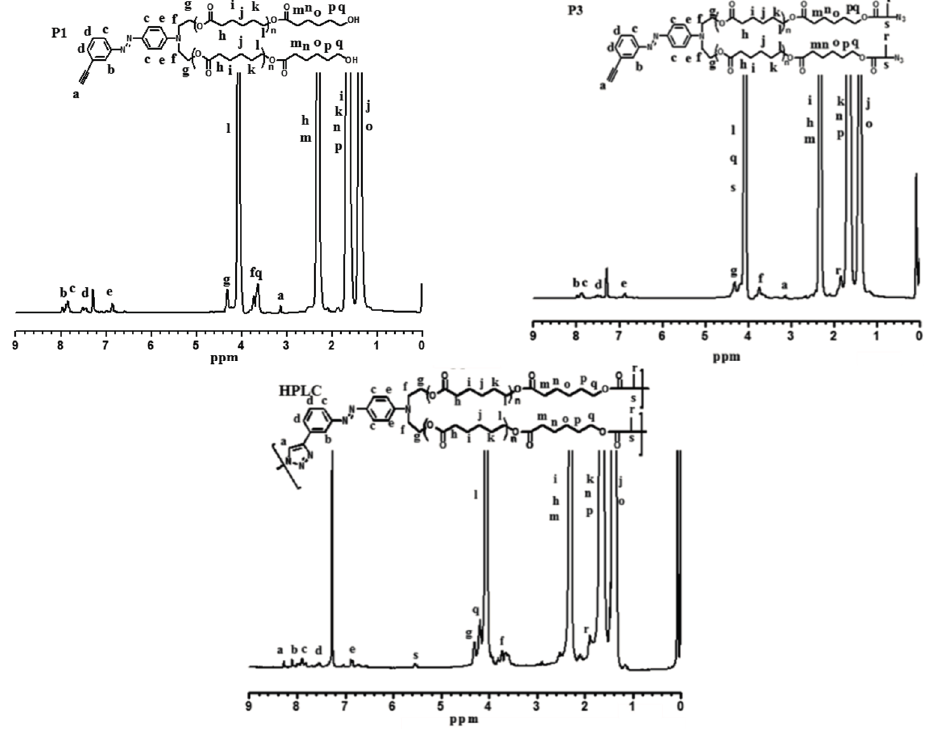
Figure 4. 1 H NMR spectra of the linear poly( ε -caprolactone) (P1, M n GPC = 7400 g/mol, M w / M n = 1.15), AB 2 macromonomer (P3) containing terminal ethyne and azide groups and hyperbranched poly( ε -caprolactone) (HPCL, M n GPC = 25,500 g/mol, M w / M n =